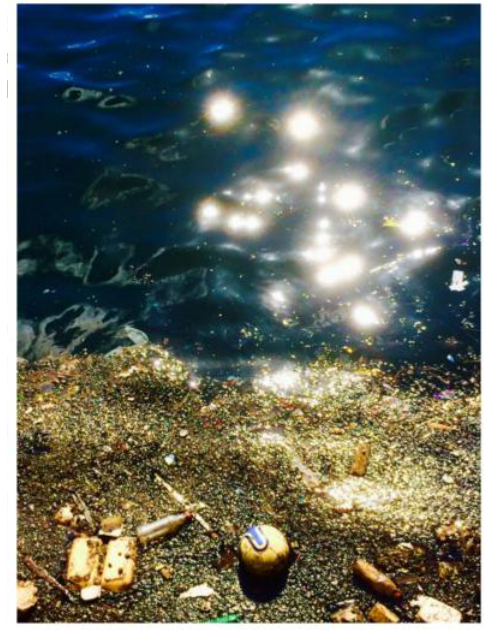
Figure 4. Flotsam and Jetsam in the